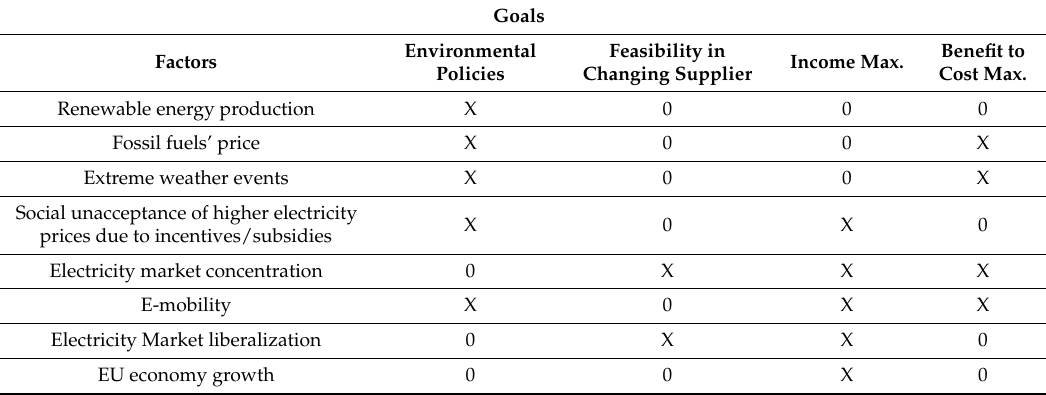
Table 5. External factors and market participants’ goals of the future electricity market.